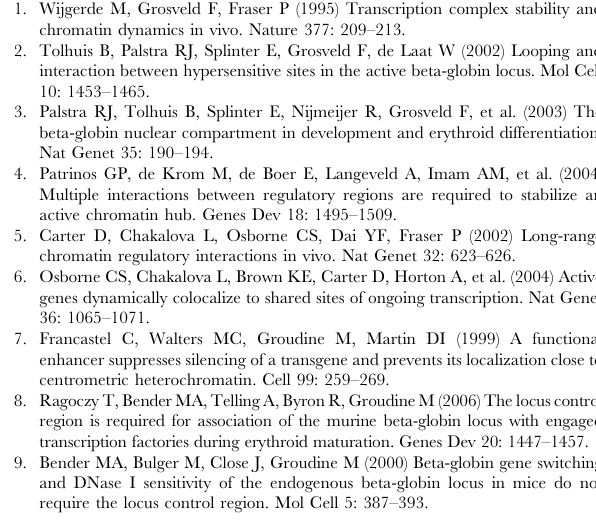
detected as a red signal by a 10 kb DIG labeled probe using Alexa Fluor 546 labeled tyramide signal amplification with DAPI counterstained nuclear DNA in green. DAPI-rich areas